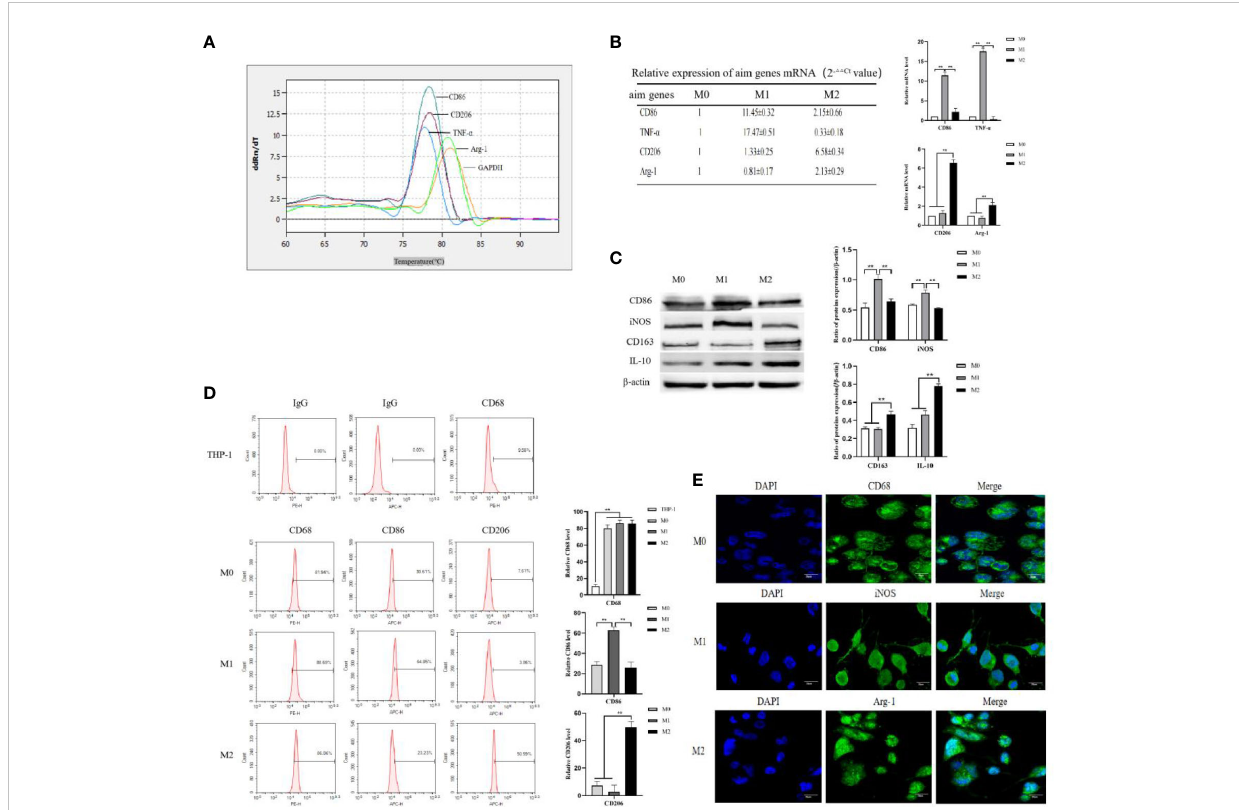
FIGURE 1 THP-1 monocytes were induced to polarize toward M0, M1 and M2 macrophages. (A) M0-type macrophages were induced to polarize toward M1- or M2- type macrophages using LPS+IFN- g and IL-4+IL-13, respectively, for 72 h. Real-time PCR was used to detect the Ct values of the M1-type macrophage markers CD86 and TNF- a and the M2-type macrophage markers CD206 and Arg-1. Melting curve comparison of the relative mRNA expression levels of each target gene in M0, M1 and M2 macrophages. (B) The expression of each target gene in M0 macrophages was used as a control. The relative mRNA expression levels of each target gene in M1 and M2 macrophages were calculated by the 2- △△ Ct method. The right column diagrams display the statistical differences in relative mRNA expression levels in each group, ** P <0.01. (C) Protein expression of the M1-type macrophage markers CD86 and iNOS, and the M2-type macrophage markers CD163 and IL-10 detected by Western blotting; the right column diagrams display the expression levels of proteins in each group that were statistically analyzed by gray scanning, ** P <0.01. (D) Expression of CD68 in the IgG isotype control and THP-1 cells; expression of CD68, CD86 and CD206 in M0, M1 and M2 macrophages detected by fl ow cytometry; the right column diagrams display statistical analysis of the expression of CD68, CD86 and CD206, ** P <0.01. (E) The expression of the macrophage markers M0 (CD68), M1 (iNOS) and M2 (Agr-1) was observed by laser confocal microscopy. The results of the at least three independent experiments are